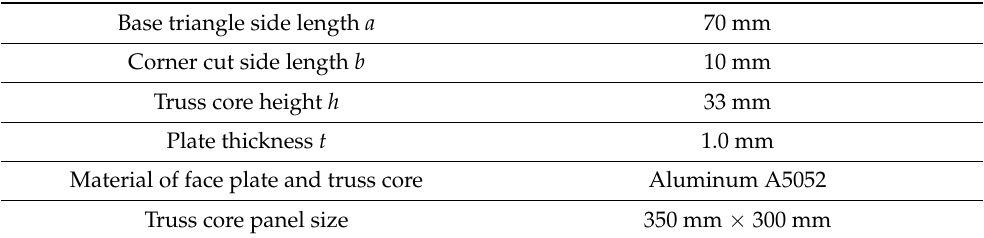
Table 1. Details of the truss core panel examined in this study.